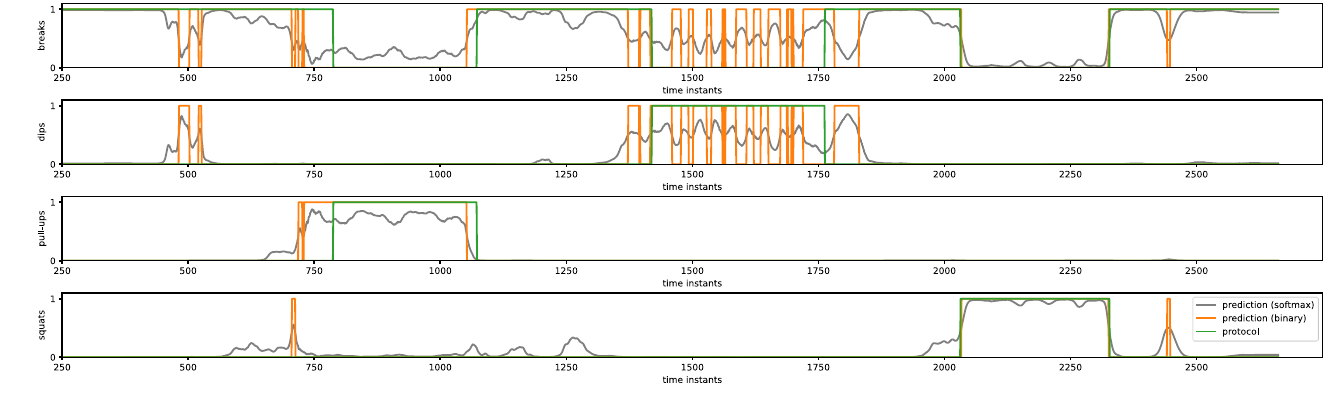
Figure 6. An exemplary result of live signal processing.